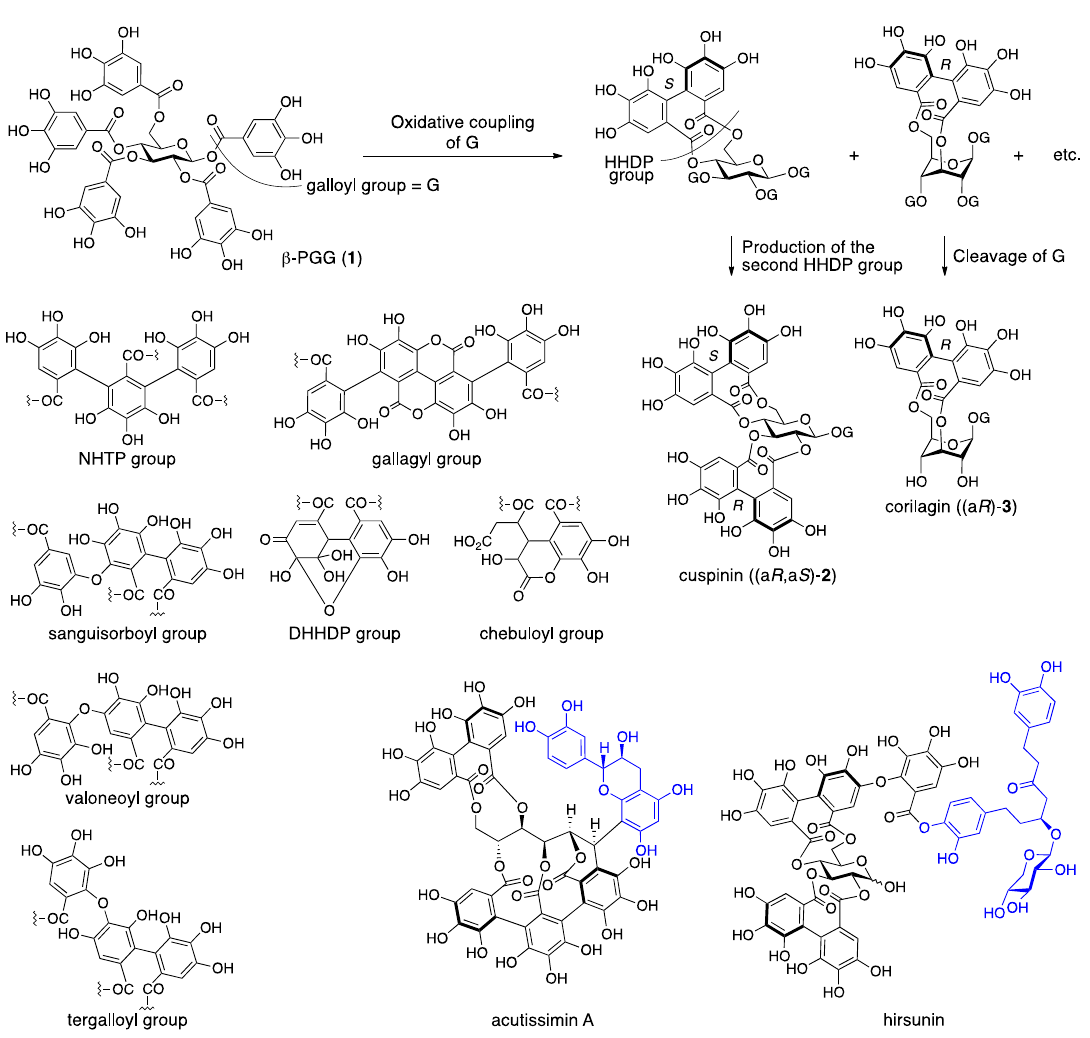
Figure 1. The oxidative intramolecular coupling of the galloyl groups and the structures of components of ellagitannin, acutissimin A, and hirsunin.